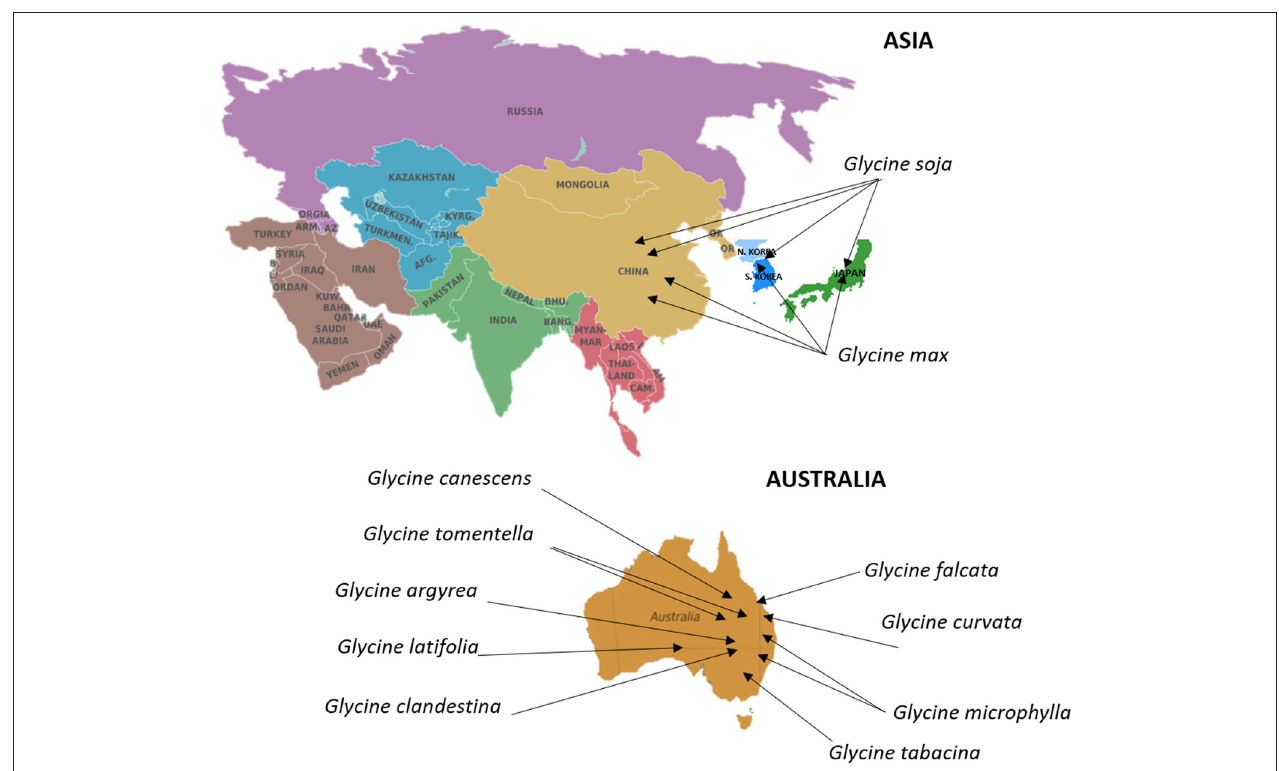
FIGURE 4 | Centers of origin and primary geographical distribution of cultivated soybean and its wild relatives. Information on the distribution and centers of origin was gathered from Brown et al. (1989), Sherman-Broyles et al. (2014), Zhou et al. (2015). The Germplasm Resources Information Network in Beltsville, USA (https:// npgsweb.ars-grin.gov/gringlobal/search.aspx) stores large global collection of soybean cultivars. Commonwealth Scientific and Industrial Research Organization in Canberra, Australia, encompasses a major collection of wild Glycine